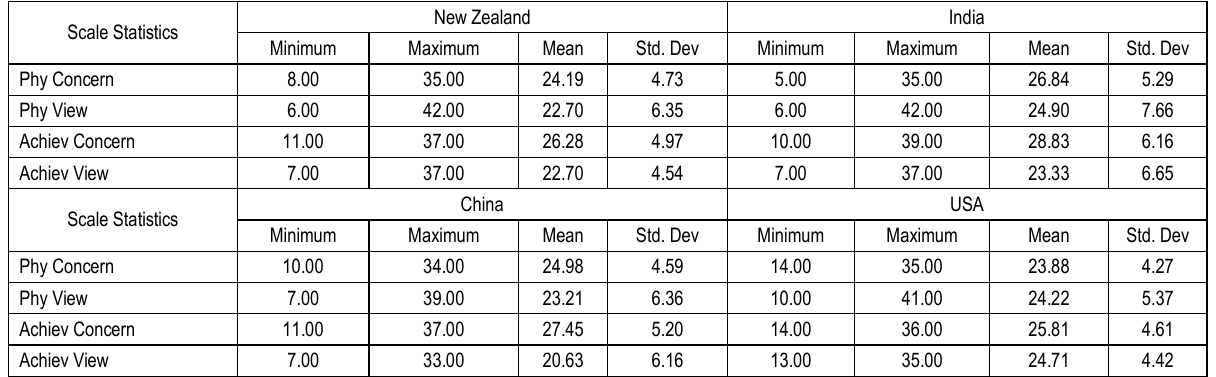
Table 5. Reliability coefficients and inter-scale